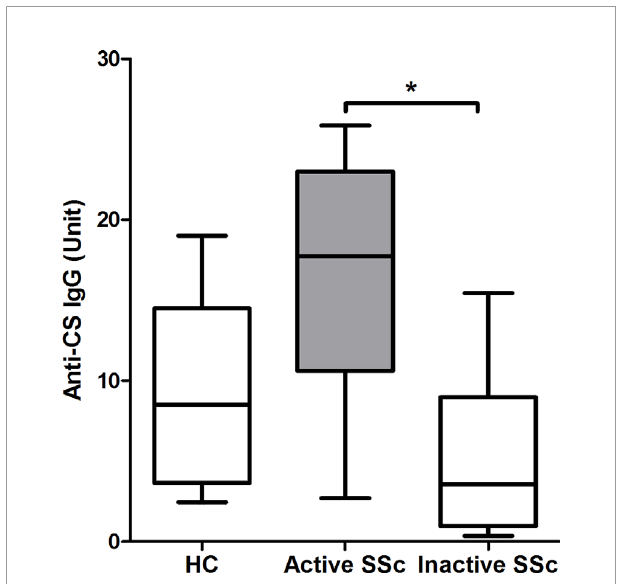
FIGURE 6 | Relationship between disease activity and anti-citrate synthase (CS) IgG antibody titers in SSc patients (n = 14) and HCs (n = 13). The boxes show interquartile ranges (IQR), the horizontal lines represent medians and the whiskers indicate the lowest and highest values. *p